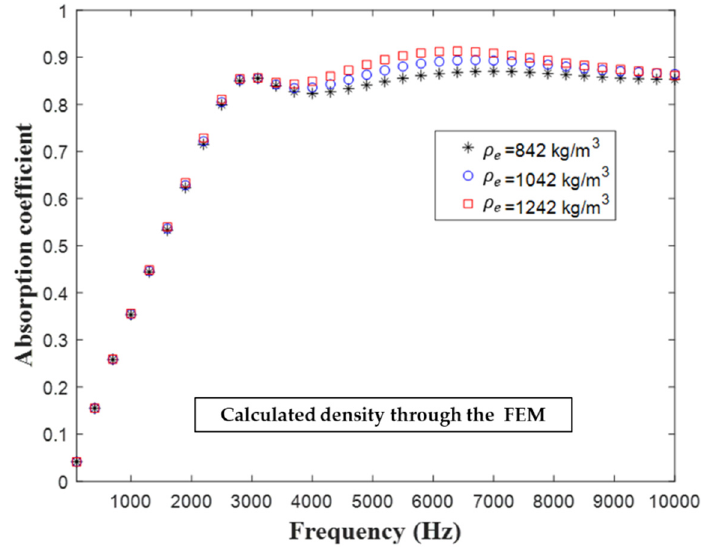
Figure 17. Influence of substrate density of the substrate of the hybrid metastructure on the structure’s sound absorption coefficient.